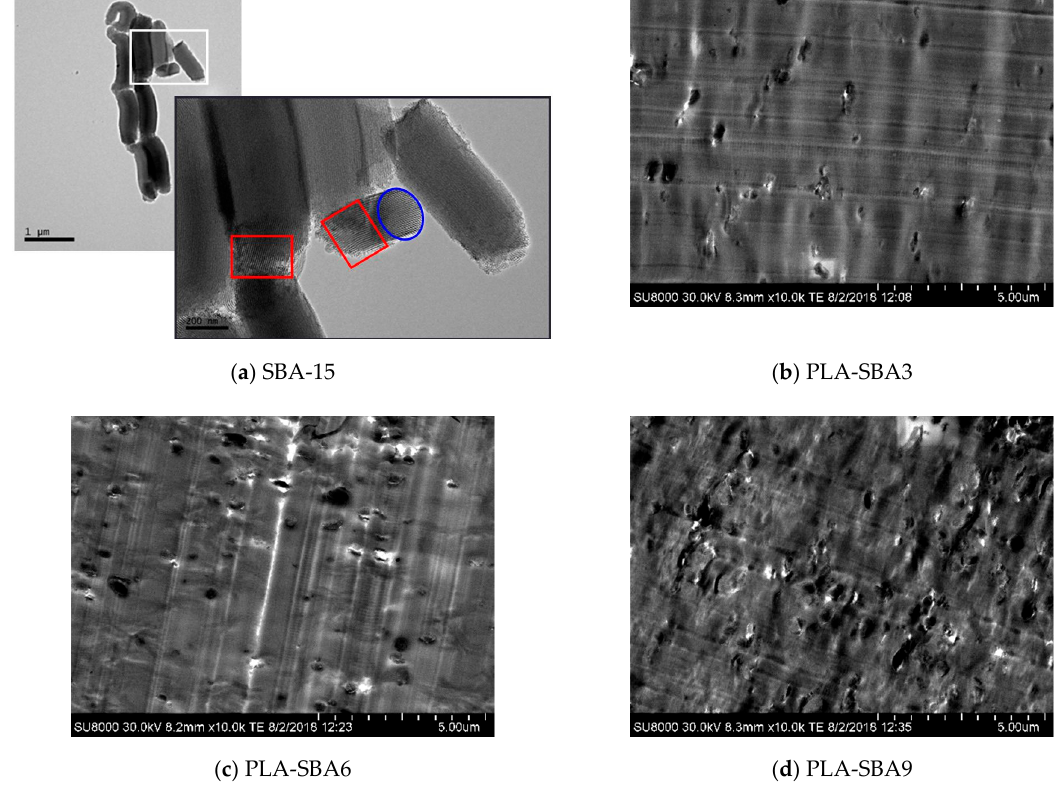
Figure 1. ( a ) TEM images of SBA-15 particles at a scale bar of 1 µ m (left) and its magnification at 200 nm (right). FESEM micrographs for di ff erent composites: PLA-SBA3 ( b ), PLA-SBA6 ( c ), and PLA-SBA9 ( d ) at a scale bar of 5 µ m.